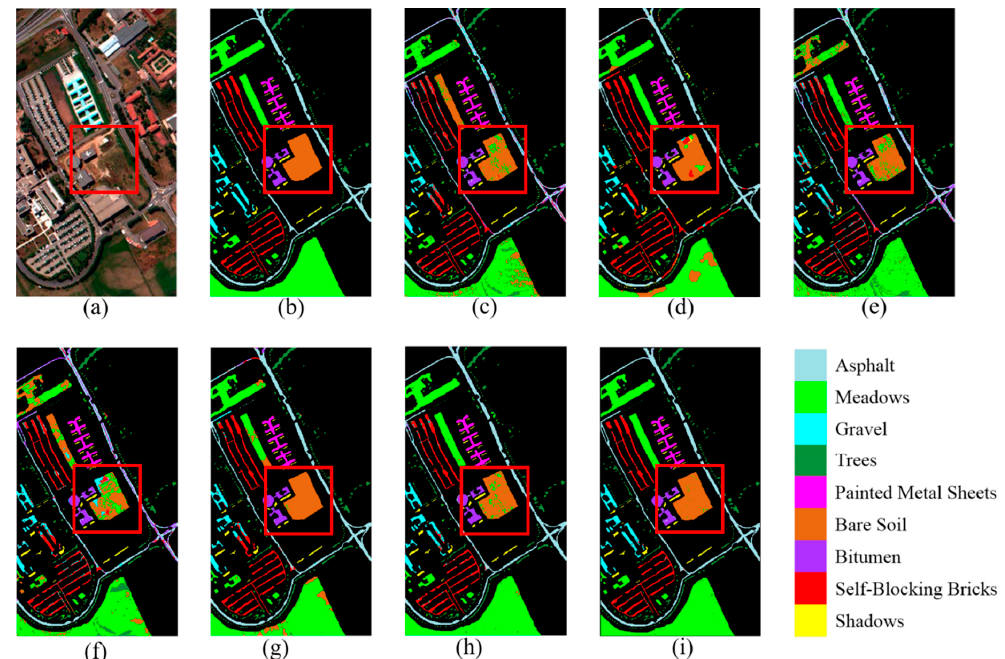
Figure 7. Classification maps of University of Pavia dataset. ( a ) True color image. ( b ) Reference image. ( c ) CCF. ( d ) SVM-3DG. ( e ) 2D-CNN-transfer. ( f ) 3D-CNN. ( g ) SSRN. ( h ) MSDN. ( i ) MSDN-SA.